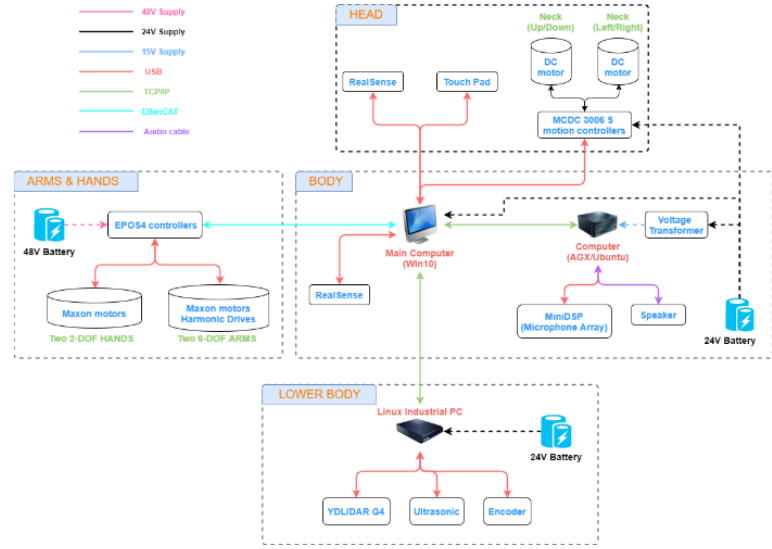
Figure 14. The hardware architecture of the mobile-robot system.